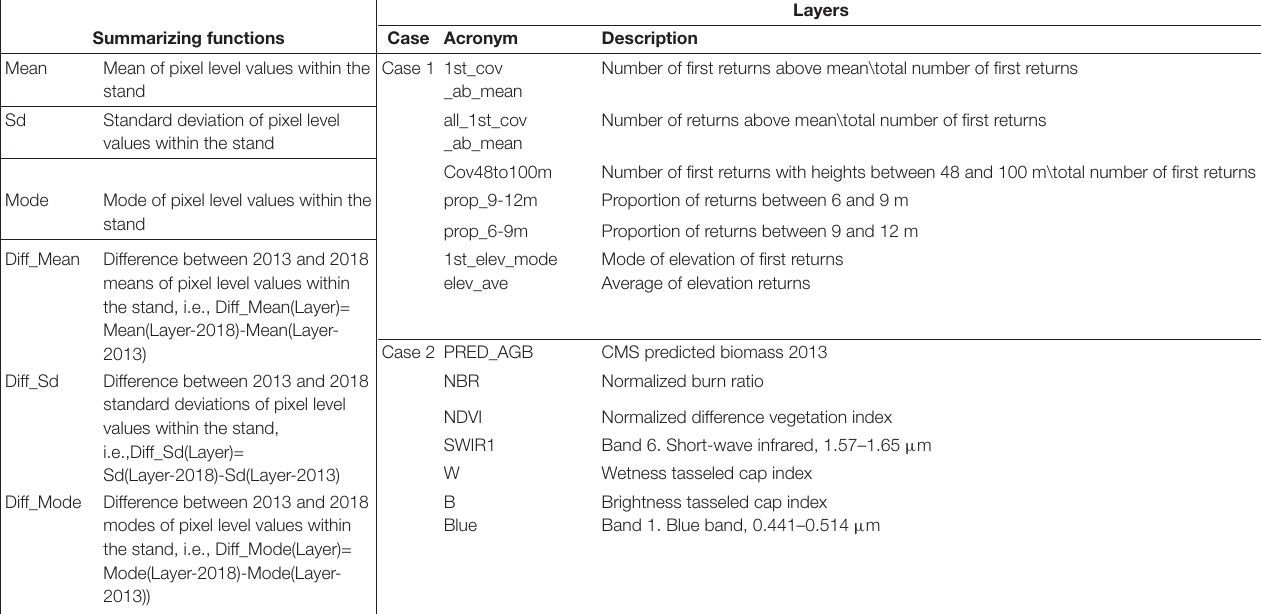
TABLE 3 | Stand-summarizing functions applied to the 30 m resolution layers of auxiliary variables and description of metrics included in the selected